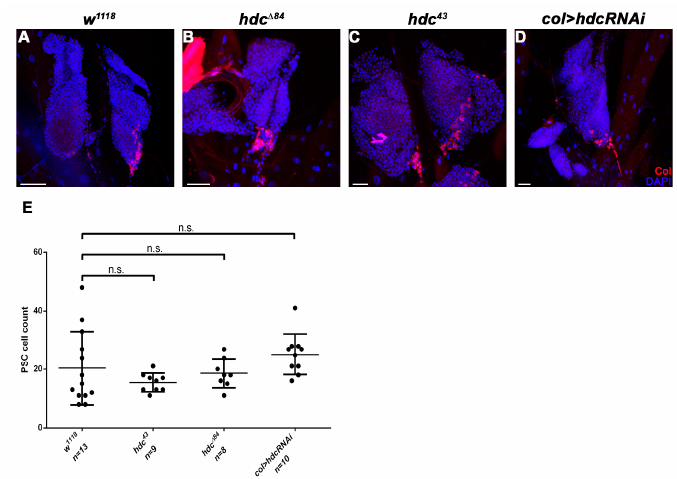
Figure A2. PSC integrity in hdc -mutant and hdc -silenced larvae. ( A – D ) PSC integrity in w 1118 control larvae ( A ) is similar to that observed in the hdc ∆ 84 ( B ) and hdc 43 ( C ) mutants. Silencing of hdc ( D ) in the PSC with the col-Gal4 driver ( Pcol85-Gal4, UAS-hdcRNAi/+ ) had no effect on the integrity of the PSC. The cells of the PSC (red) were stained with the anti-Collier antibody. Nuclei were stained with DAPI (blue). Images were taken with a Leica TCS SP5 Confocal Microscope, original magnification × 20, and processed with LAS AF Lite (Leica Microsystems CMS GmbH), ImageJ and Adobe Photoshop CS2 software. Scale bars: 25 µ m. ( E ) No significant difference was detected in the number of PSC cells in the lymph gland of either of the hdc -mutant or the hdc -silenced larvae compared to the w 1118 control. Error bars represent the standard deviation of the mean. ns: non-significant. Significance was determined by unpaired Student’s t -test using GraphPad Prism 6.